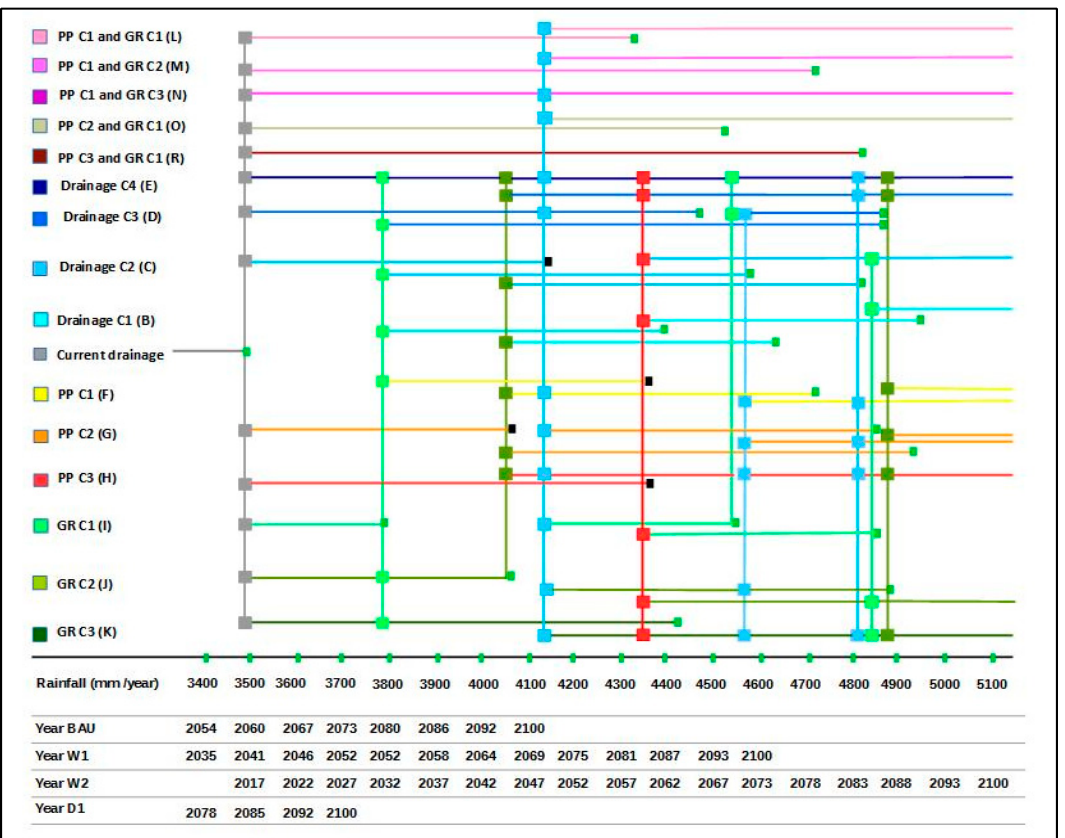
Figure 4. Adaptation Pathways Map, for the current land use and all climate scenarios. Porous Pavements are abbreviated as PP and green roofs are abbreviated as GR. Adapted from [39].